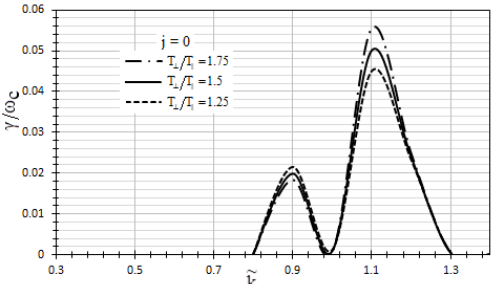
Fig.1: Variation of Growth Rate with respect to various values of at other plasma parameters being TT  || B o = 80 nT, K B T || =400eV, n o =1x10 6 m -3 and θ=30˚.